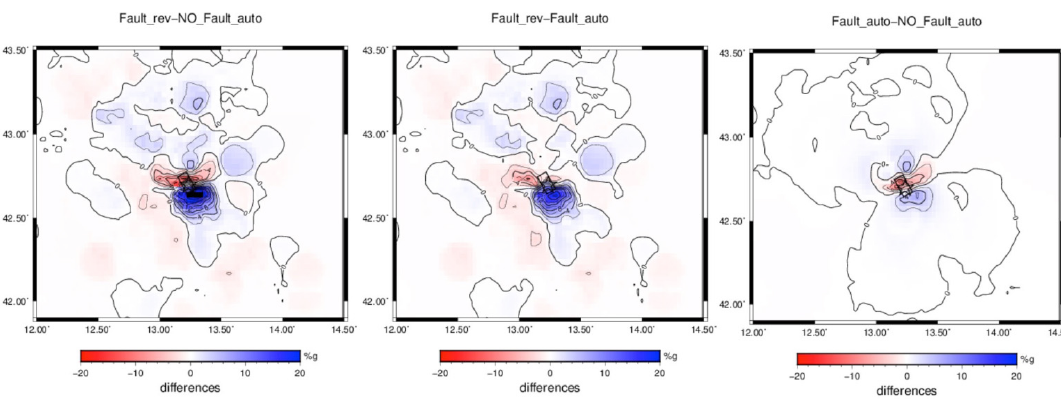
Figure 4. Differences between the different PGA shakemaps. Left: final shakemap with revised data and fault map com- pared with automatically processed data and no fault; center: final shakemap with revised data and fault map compared with automatically processed data and fault inserted; right: shakemap with fault and automatically processed data com- pared with the same data but no